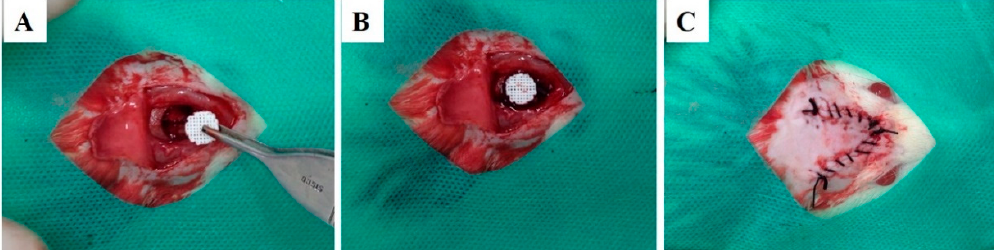
Figure 2. Surgical procedures for scaffold implantation in 8 mm calvaria defect. Surgical bone defect ( A ), scaffold implantation in situ ( B ) and defect sutured ( C ).